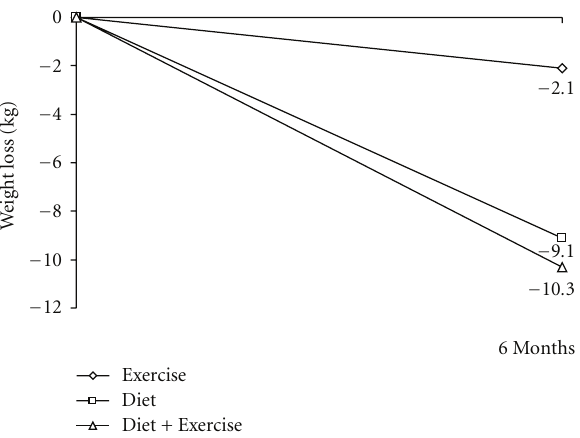
Figure 1: Weight loss related to an exercise intervention, a diet intervention, and a diet + exercise intervention. The magnitude of weight loss due to physical activity is additive to caloric restriction, but physical activity is generally insu ffi cient by itself to bring about clinically significant weight loss, that is, a decrease of 5% or more in body weight. Figure adapted from Wing